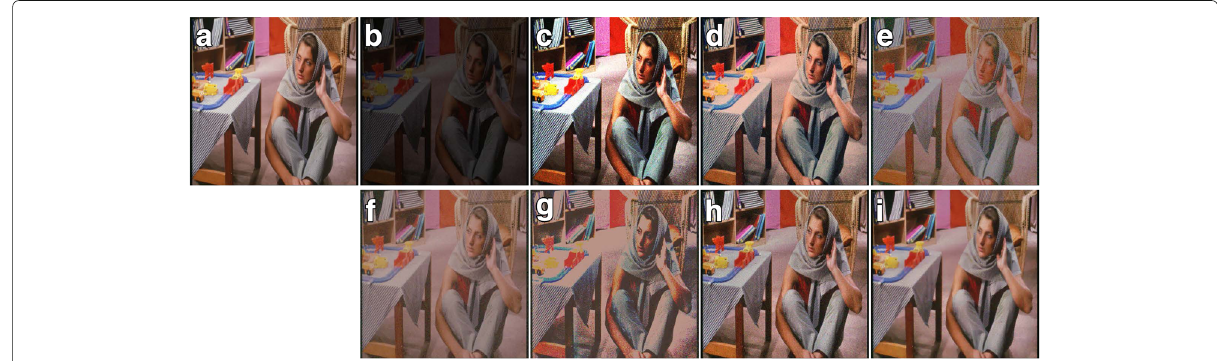
Fig. 5 Comparative results using simulated low-light image with σ = 5: a input image, b simulated low-light image, c Chen’s method [2], d Kim’s method [3], e Jiang’s method [8], f Ravi’s method [23], g Jobson’s method [14], h Fu’s method [16], and i the proposed method ( λ 1 = 300, λ 2 = 0.1, = 0.9, and ω = 10) λ 3